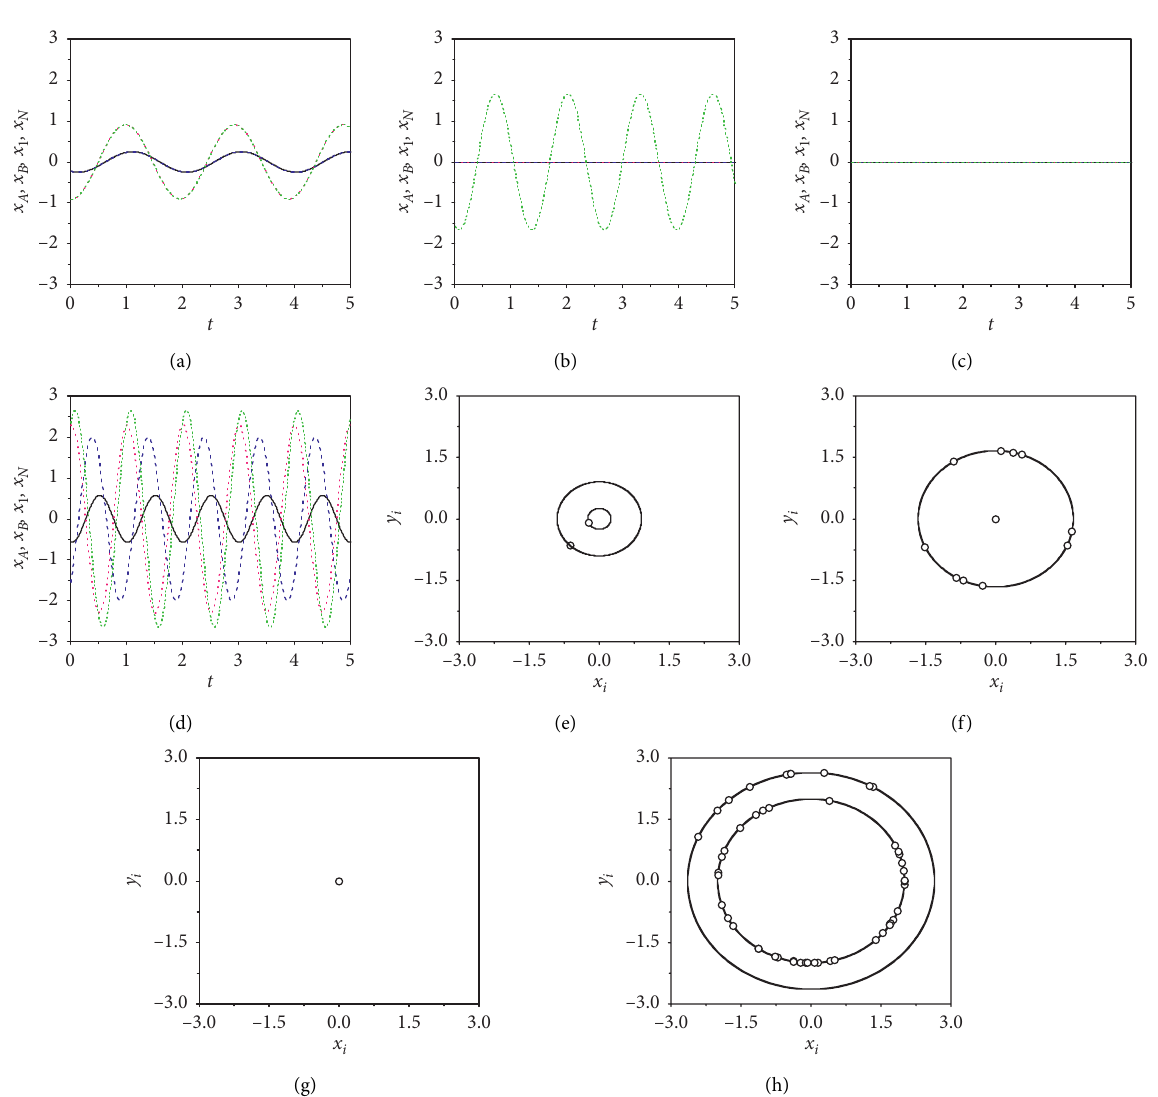
� ( 1/ pN ) 􏽐 pN x x � ( 1/ ( 1 − p ) N ) 􏽐 N x x ( t ) (blue dash line), A j (black solid line), B j (pink dot line), j � 1 j � pN + 1 1